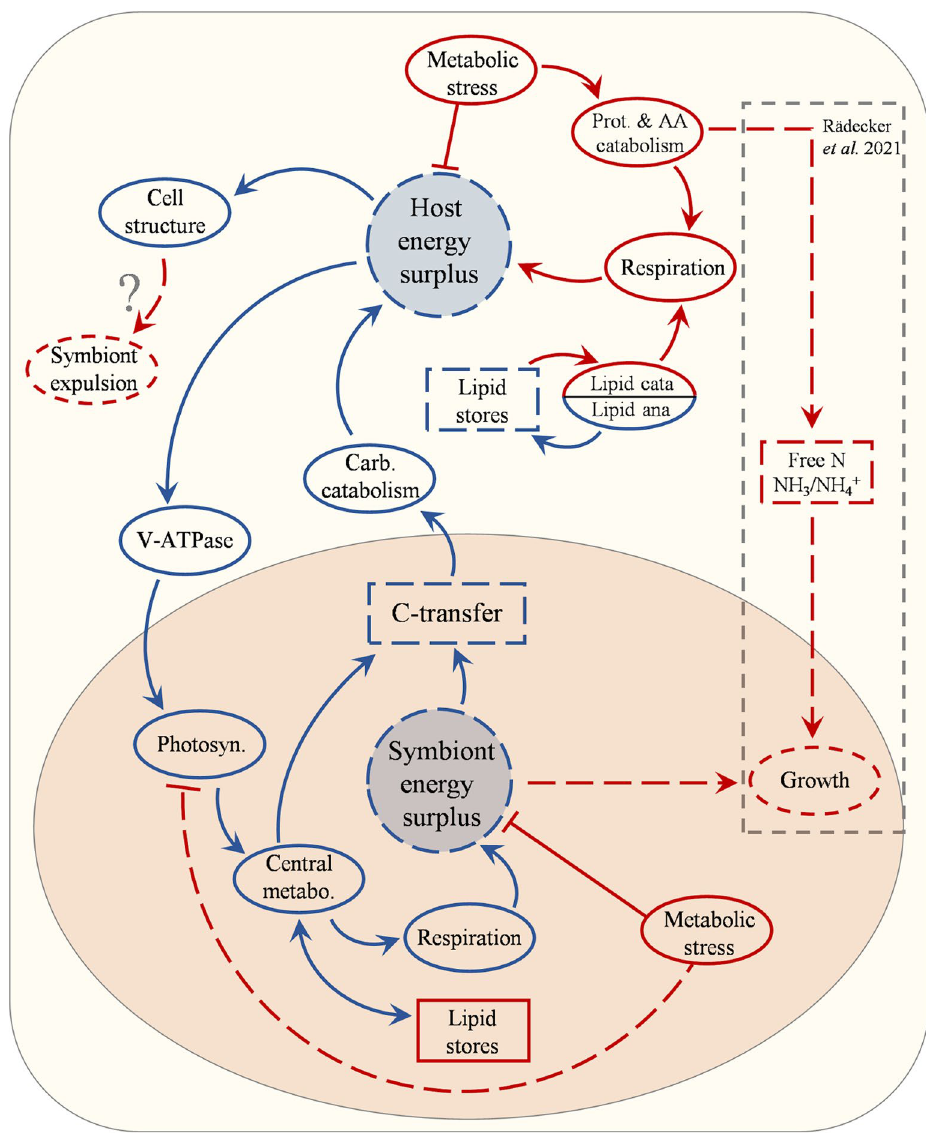
Figure 5. Hypothesised mechanism for coral symbiosis destabilisation based on proteomic analysis of Acropora millepora and its associated symbionts under thermal stress. Elevated temperature induces metabolic stress in the host causing protein destabilisation and increase in respiration. Protein degradation leads to the release of free amino acids, which together with lipids, are degraded to support the increased respiratory demand. Due to less energy available, the energetically expensive symbiosome membrane protein V-ATPase declines, reducing inorganic carbon availability to the symbiont, thus reducing photosynthetic activity. This leads to reduced activity in the central metabolic processes in the symbionts (carbohydrate and lipid metabolism). The overall lowered metabolic activity of the symbiont together with increased housekeeping requirement, due to increased temperature, reduces the pool of surplus energy and excess carbon available for transfer to the host, which subsequently experiences further energy limitation. The evidence obtained in this study supports the hypothesis presented in Rädeker et al . (2021), whereby the reduction in carbon transfer is the mechanism underlying the breakdown of the symbiotic relationship in corals. While we did not obtain direct evidence for the process of increased growth in the symbionts from availability of free nitrogen as proposed by Rädecker et al . (2021), the mechanism fits the scheme suggested here and would exacerbate the strength of the response. Ultimately, the lowered energy available in the host leads to degradation of major cellular structural components which could lead to expulsion of the symbionts from the host tissue. Blue indicates decrease, red indicates an increase. Solid lines indicate processes or pools for which evidence was obtained in this study, stippled lines indicate processes or pools that are hypothesised to change or have been shown to change by Rädecker et al . (2021). Arrows indicate positive effect and blocked lines negative